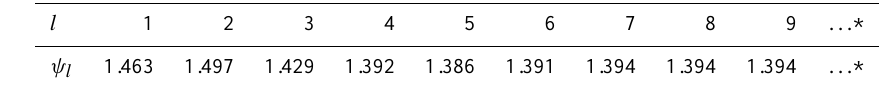
Table 4. The ψ weights for time series v t in stage 1.